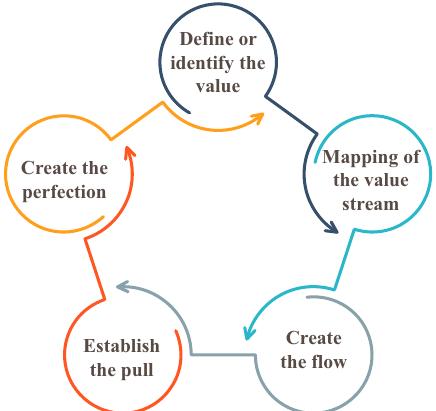
Fig. 2 Sequence of Lean principles (source: created by the authors based on Allen,